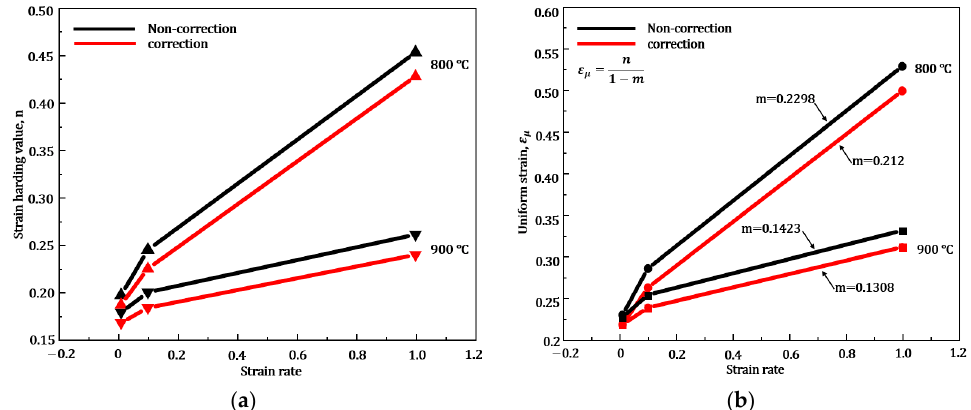
Figure 11. Hardening component of corrected TA32: ( a ) strain hardening component, n; ( b ) uniform strain, ε u , and strain rate hardening component, m.